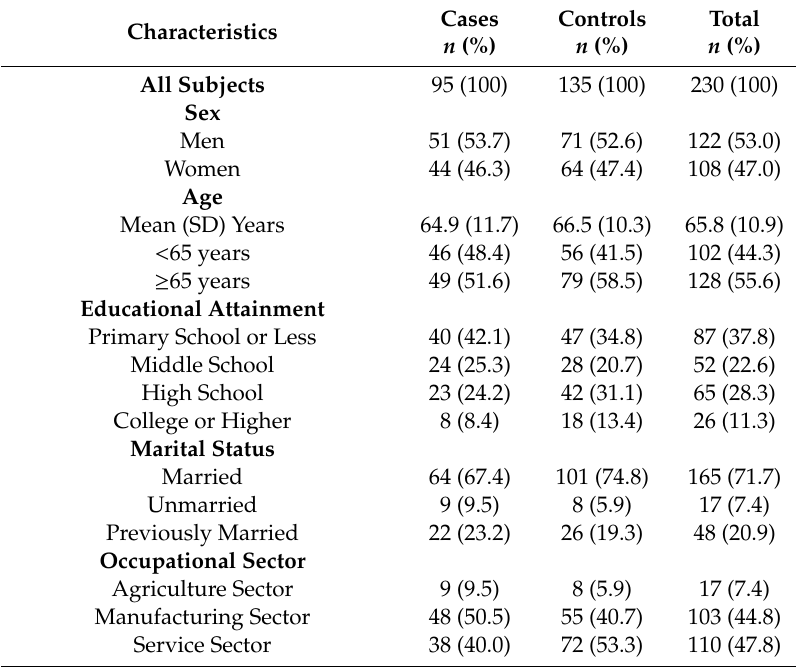
Table 1. Characteristics of study